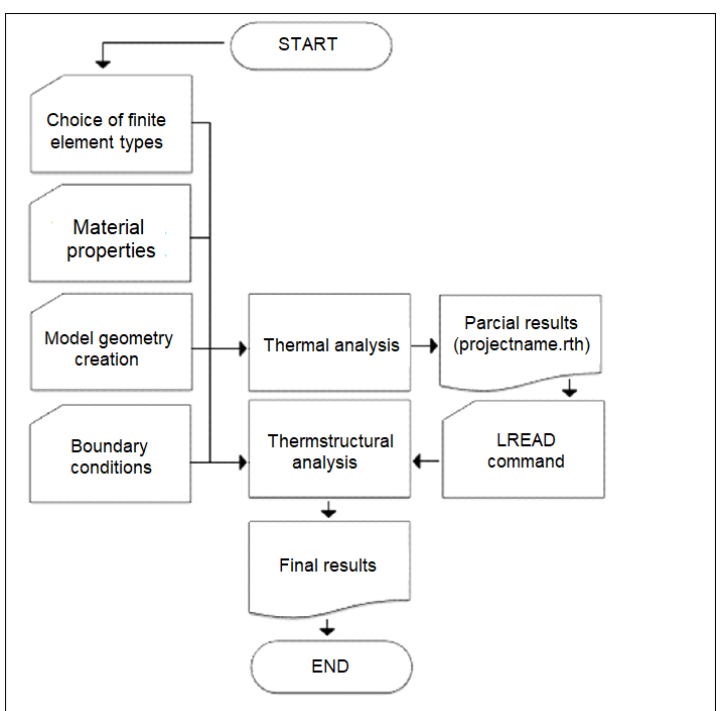
Figure 3. Coupled analysis